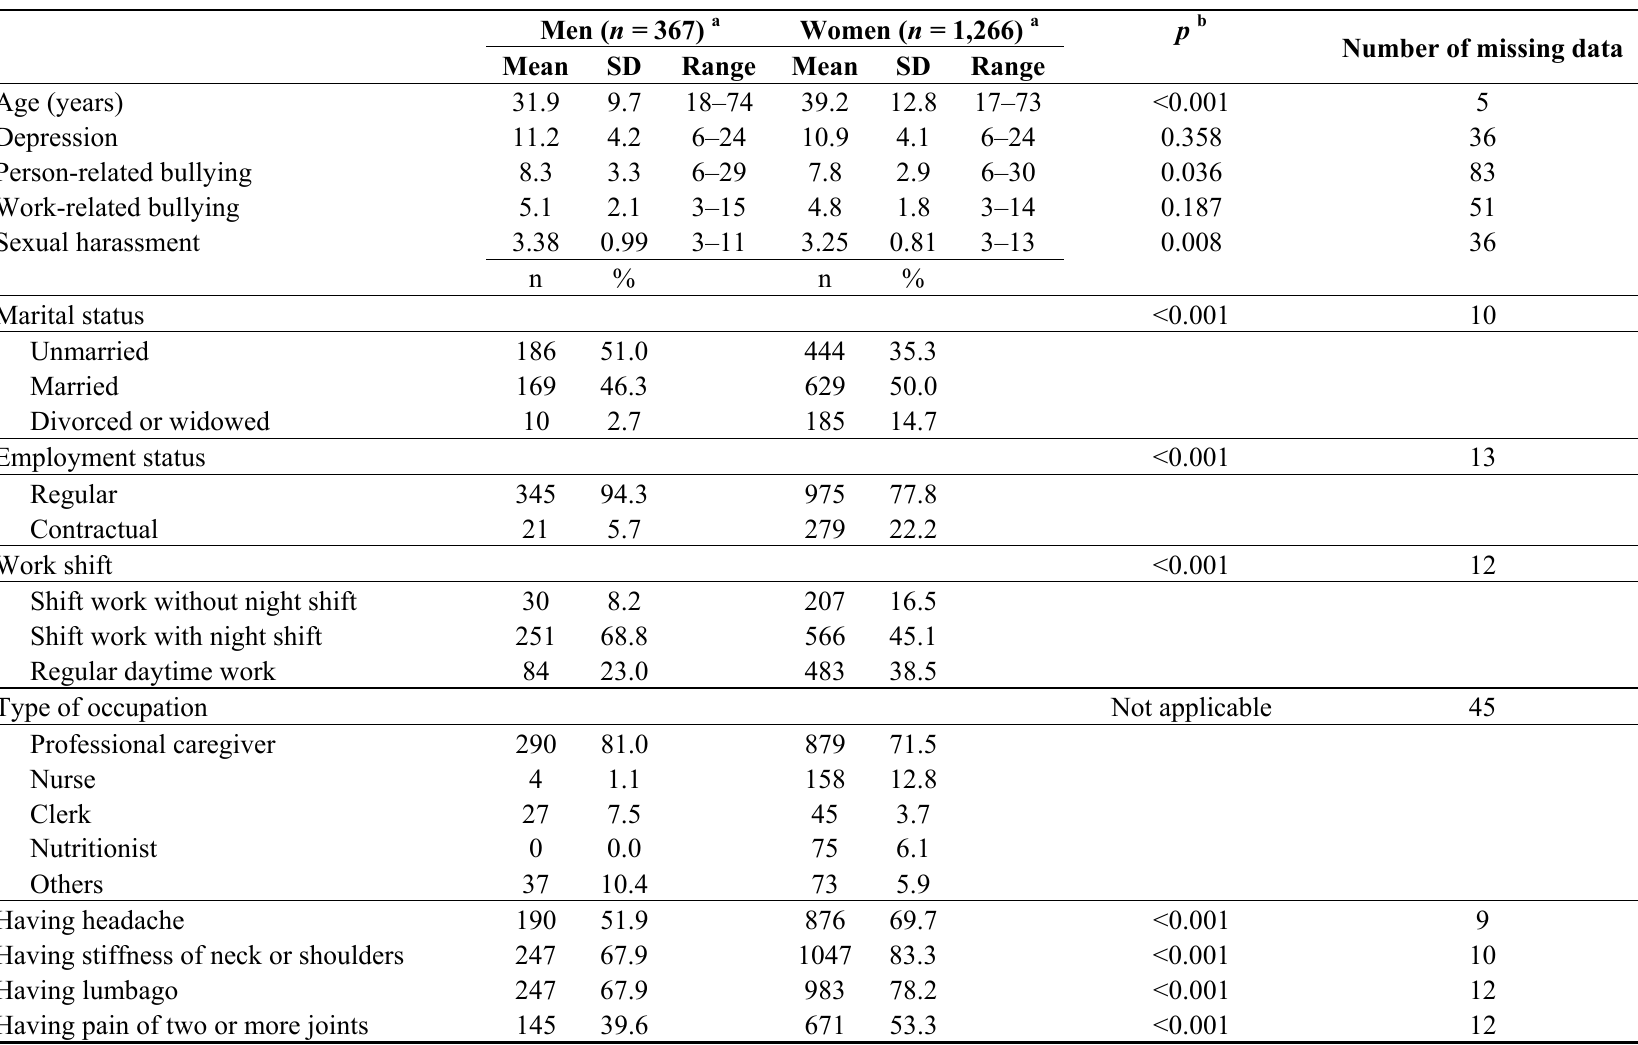
Table 1. Participant characteristics according to